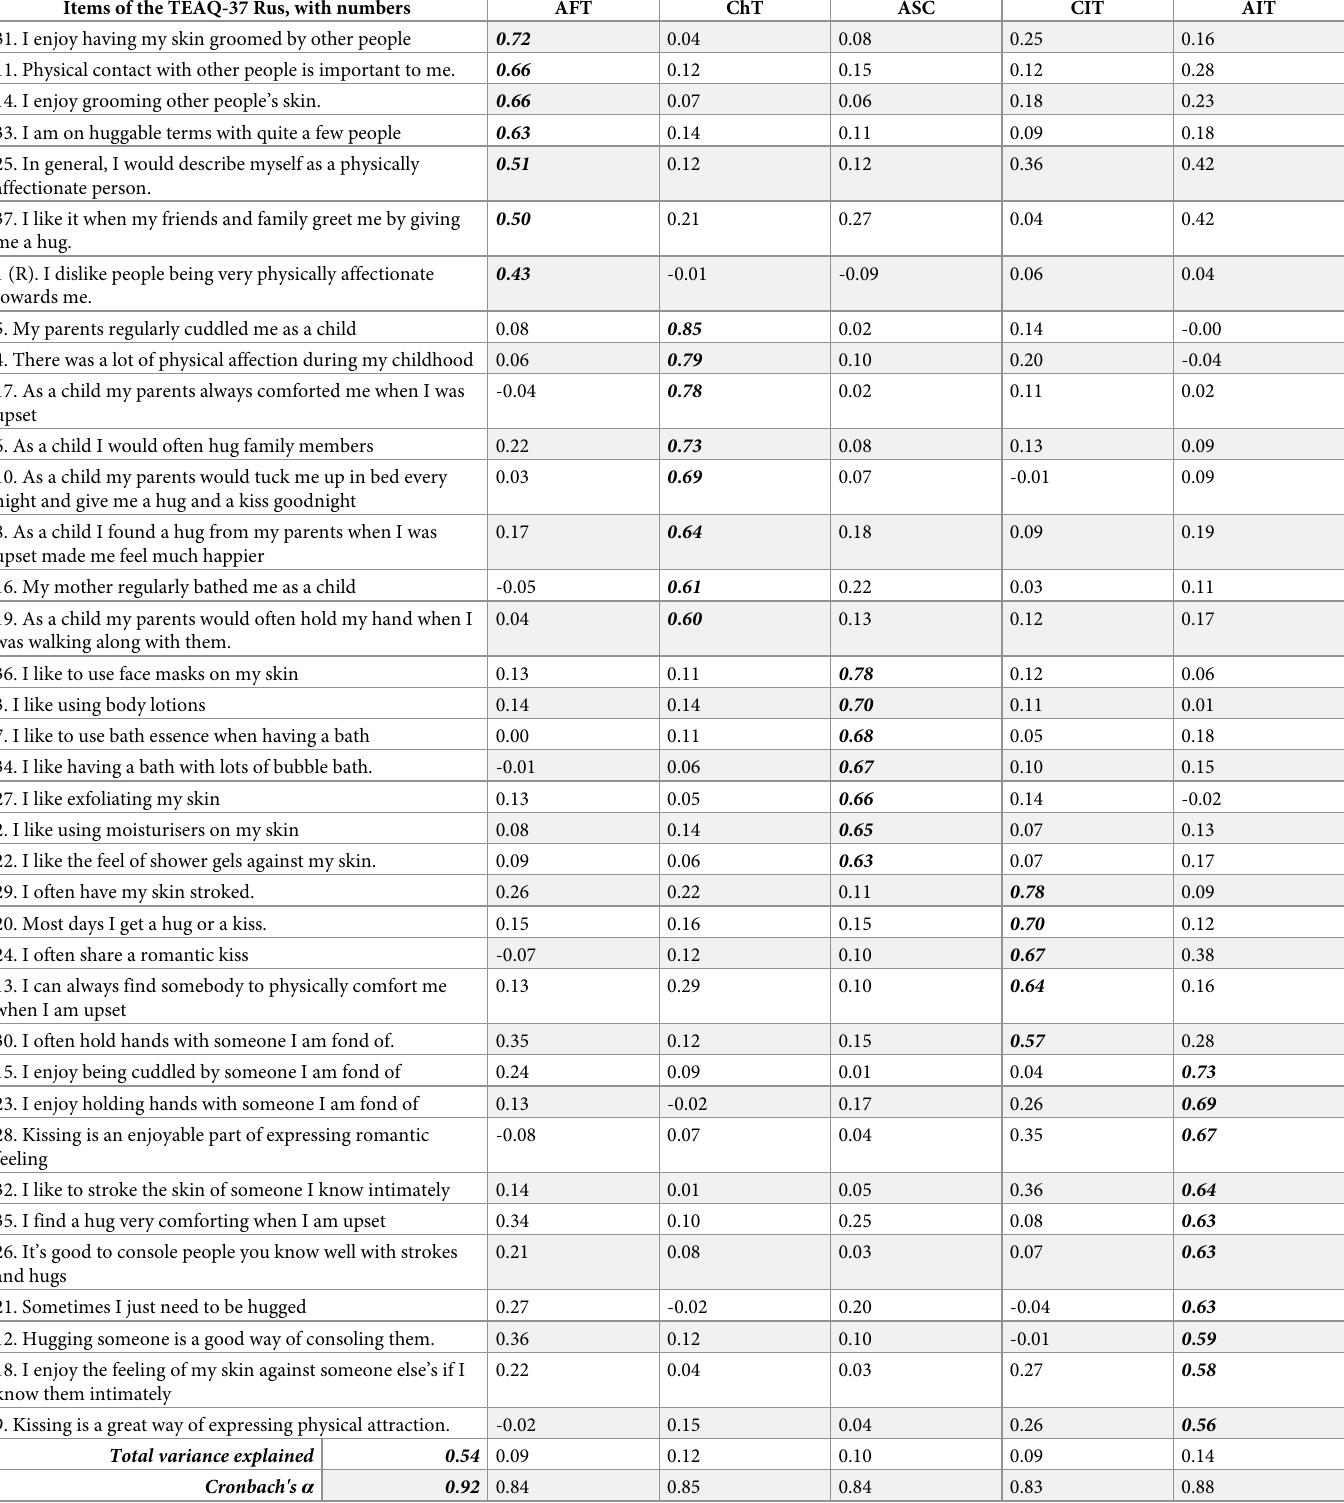
Table 3. TEAQ-37 Rus factor structure. Factor loading of each item are shown. (R) after item numbers denotes reverse scored items. At the bottom of the table Cronba- ch’s α and percentage variance explained by each factor are given. Items of the TEAQ-37 Rus, with numbers AFT ChT ASC CIT